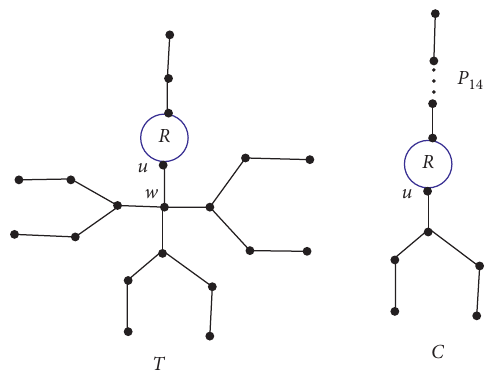
Figure 14: The trees T and C .